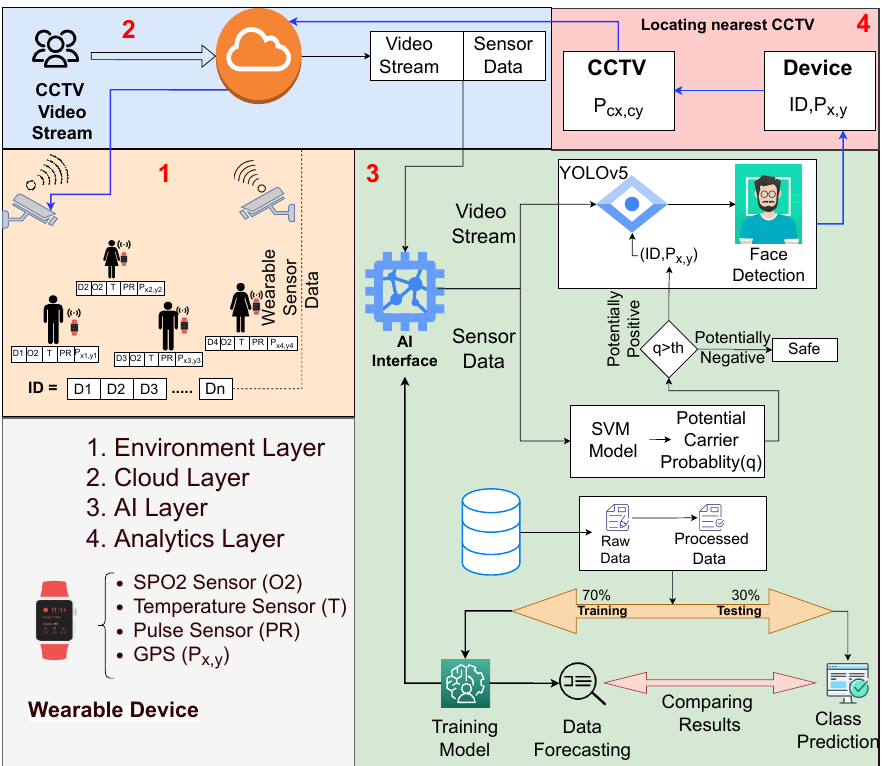
Figure 2. Proposed crowdsensing framework for real-time COVID-19 detection and tracking using wearable